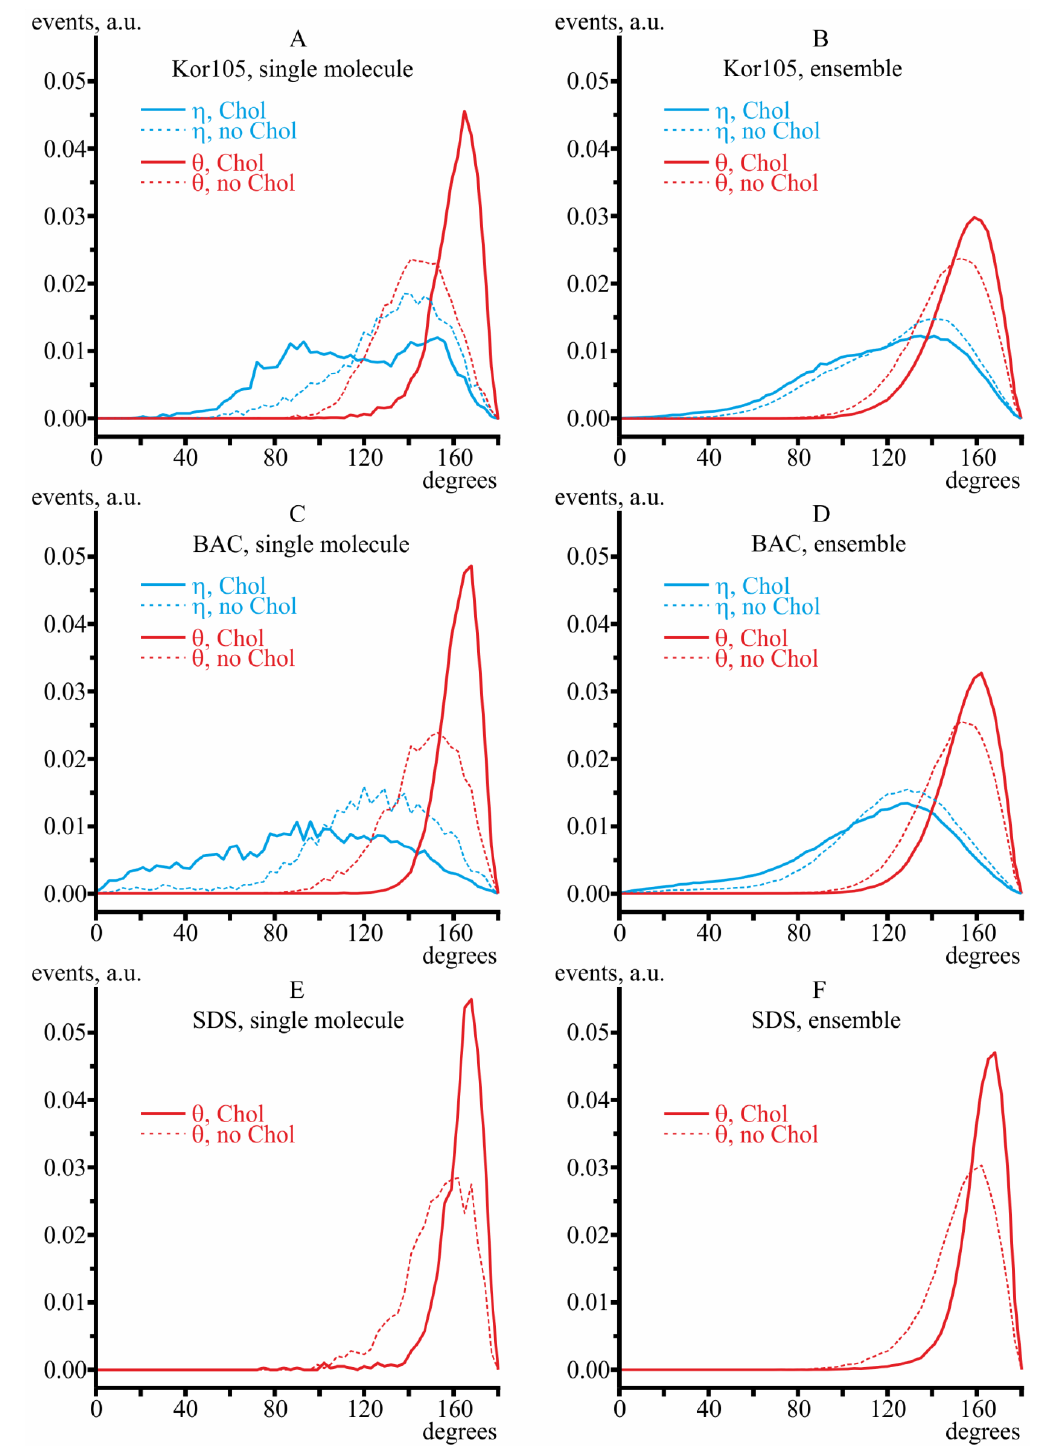
Figure 7. The density of the distribution of angles η (blue lines) and θ (red lines) for Kor105 ( A , B ) and BAC ( C , D ). The density of the distribution of the angle θ (red lines) for SDS is shown in E and F . The distributions were calculated for the case of a single molecule of hydrophobic ions in the membrane ( A , C , and E , systems lowKorDOPC, lowKorCholDOPC, lowBacDOPC, lowBacCholDOPC, lowSDSDOPC, lowSDSCholDOPC) and for the case of a high concentration of hydrophobic ions in the membrane ( B , D , and F , systems highKorDOPC, highKorCholDOPC, highBacDOPC, highBacCholDOPC, highSDSDOPC, highSDSCholDOPC); see Section 2.2 for more details on membrane composition. In all panels, thin dashed lines correspond to DOPC membranes; thick solid lines correspond to DOPC / Chol 3:2